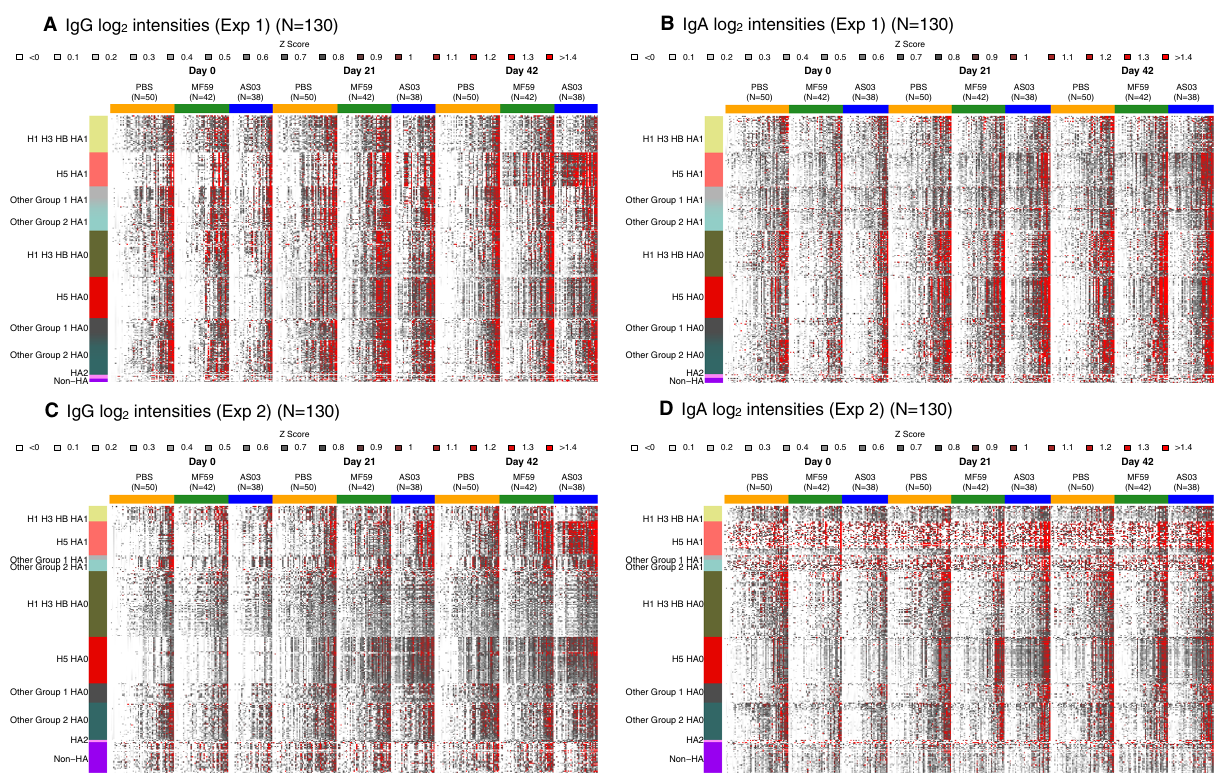
Fig. 2 Heatmaps summarizing experiments 1 & 2 protein array IgG and IgA results by vaccine group, day, HA molecule, and HA subtype. A , B log 2 fl uorescent intensity results by HA subtype for Experiment 1 IgG and IgA antibodies, respectively. C , D Corresponding results for Experiment 2. Each column represents one sample from a subject, and each row represents an antigen. The antigens are organized into groups, headgroup (HA1) or full-length molecule (HA0). The HA subtypes were grouped as H1/H3/FluB, H5, Other Group 1, and Other Group 2. Fluorescent intensities were background corrected, log 2 transformed, and standardized across rows ( z score, mean = 0, variance = 1). In red: intensities strongly increased compared to the mean log 2 intensity, in dark gray: moderately increased compared to the mean in white decreased relative to the mean. Samples were ordered by increasing